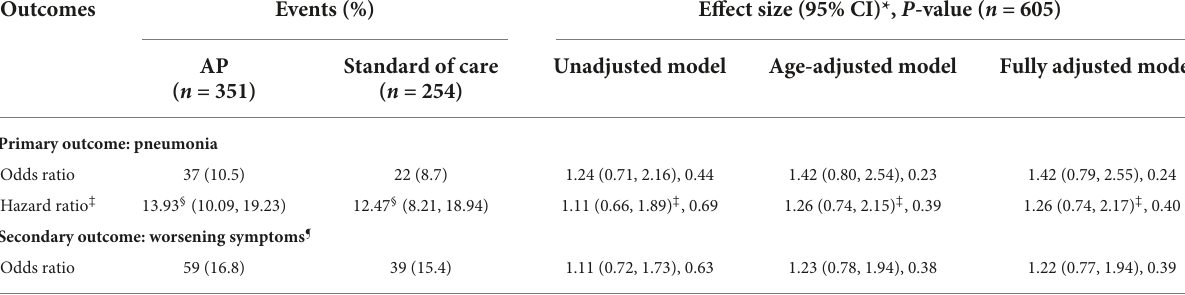
TABLE 2 Andrographis paniculata (AP) use and clinical outcomes in mild COVID-19